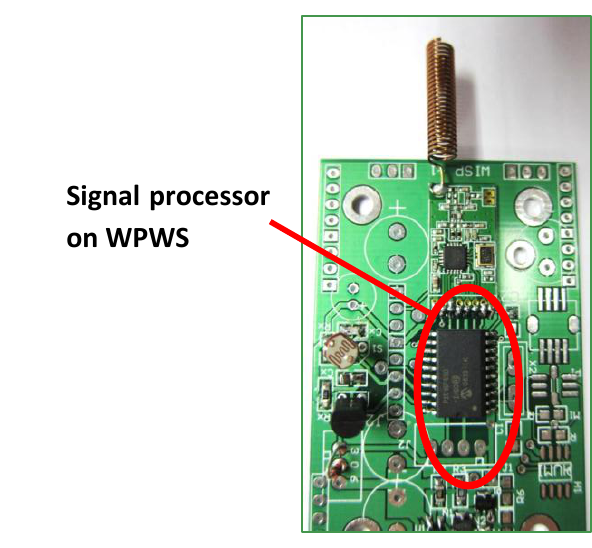
Figure 4. A commercial signal processor, the PIC17F690 chip, serves as the core of the sensor node.